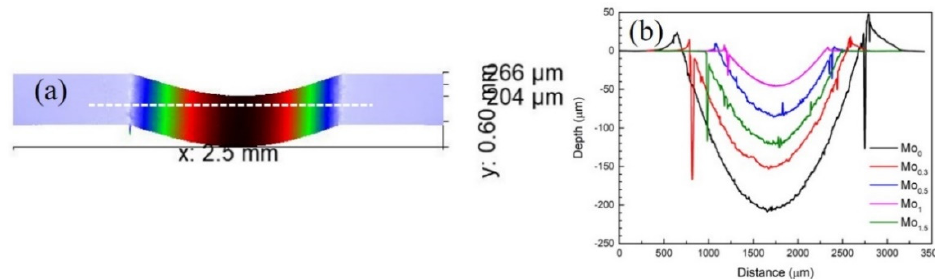
Figure 9. ( a ) Representative 3D profilometry of the wear tracks for Mo1 and ( b ) the measured wear track profiles for the wear tracks of samples with different Mo molar ratios.